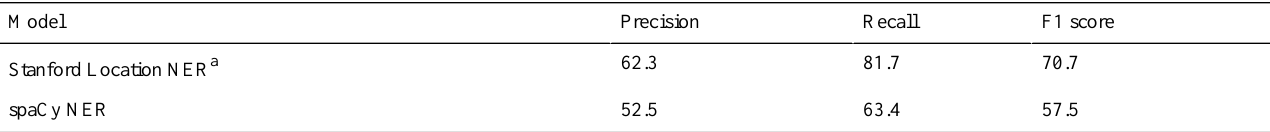
Table 4. Comparison of the two other general-purpose baselines in the task of identifying any annotated travel location, whether affirmed, negated, or